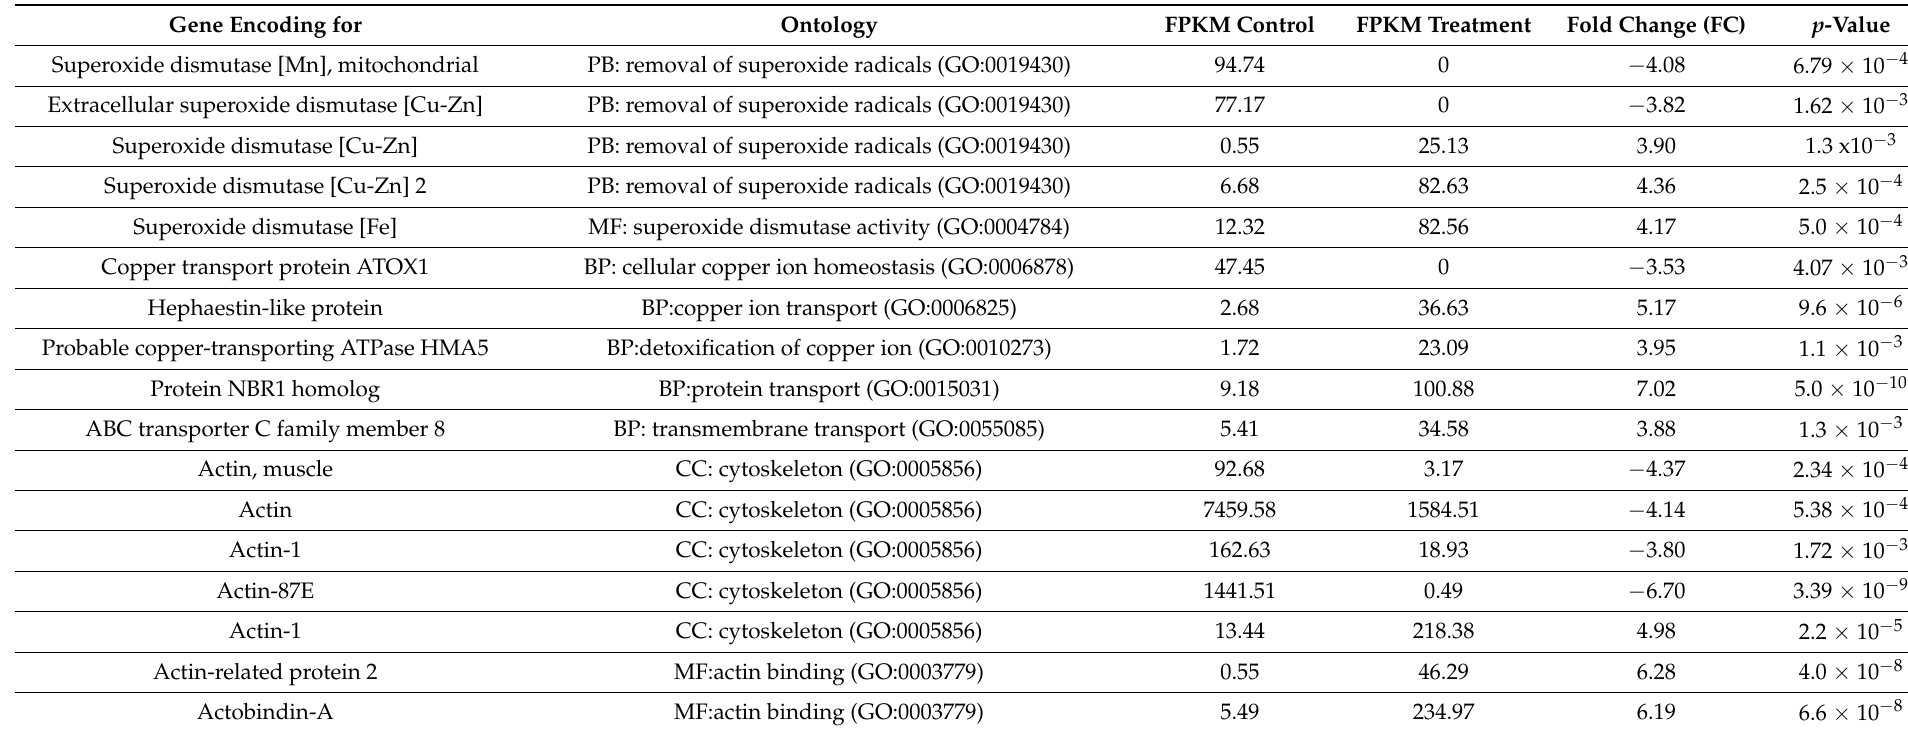
Table 4. Differentially expressed genes (DEG) related to Cu-tolerant mechanisms in roots of Imperata cylindrica plants growing under Cu stress conditions (300 mg kg − 1 ) with respect to the control condition (without Cu). Gene Encoding for Ontology FPKM